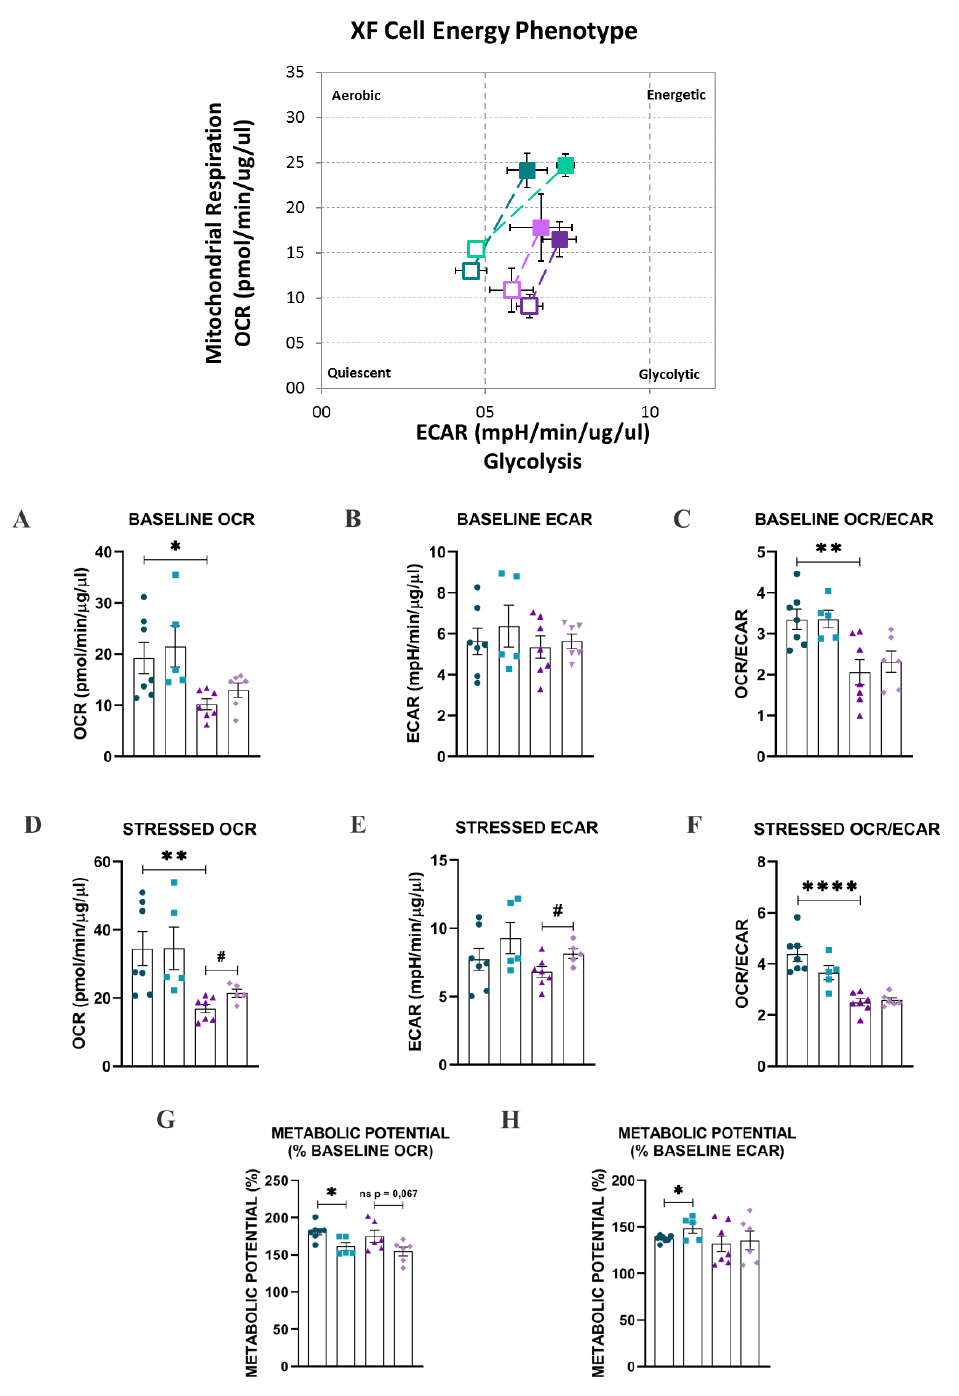
Figure 5. Effect of HG and PDGF-C on energy phenotype of HAECs. Cells were seeded in 24 well plates for Seahorse, exposed to 35 mmol/L d-glucose for 7 h without and with 50 ng/mL PDGF-C for the last hour, and energy phenotype was estimated (central upper panel. Empty squares: baseline, filled squares: stressed. Dark green: 5 mmol/L, light green: 5 mmol/L + PDGF-C 1 h, dark purple: 35 mmol/L for 7 h and light purple: 35 mmol/L + PDGF-C 1 h). ( A ) Baseline OCR, ( B ) Baseline ECAR, ( C ) Baseline OCR/ECAR ratio, ( D ) Stressed OCR, ( E ) Stressed ECAR, ( F ) Baseline OCR/ECAR ratio, ( G ) Metabolic potential (% OCR), and ( H ) Metabolic potential (% ECAR) are shown as the mean ± SEM of two independent experiments with multiple replicates (**** p < 0.0001, ** p < 0.01, * p < 0.05, and # p < 0.05 regarding HG).